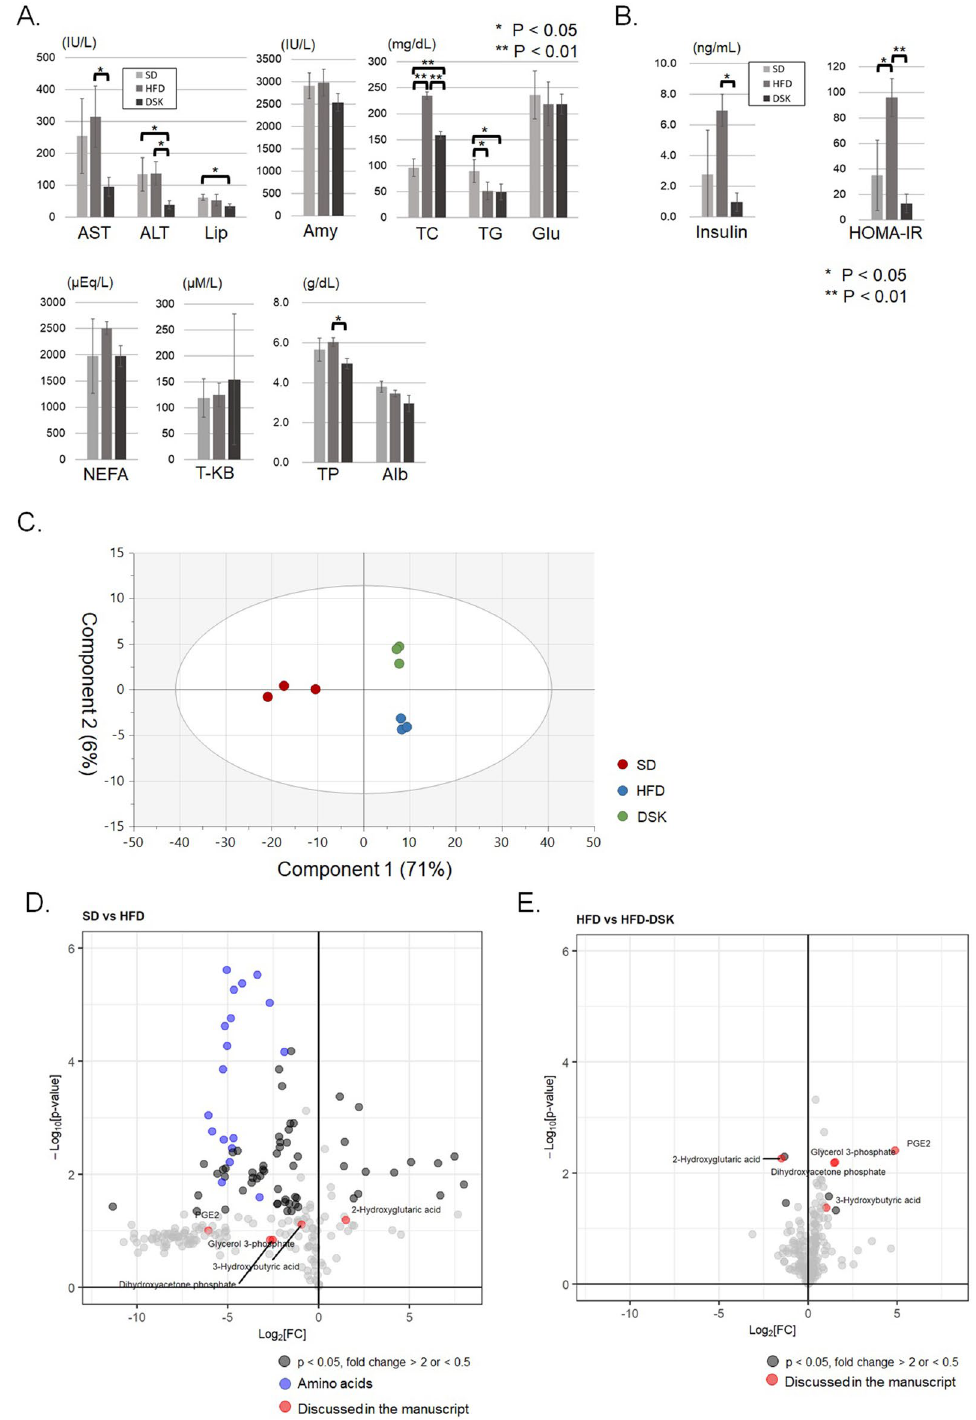
Figure 2. Effect of daisaikoto on fat metabolism in the liver. Total cholesterol and total protein levels were significantly lower in the DSK group than that in the HFD group; however, lipase, TG, glucose, and blood ketone levels were not significantly different ( A ). Serum insulin levels and HOMA-IR were significantly lower in the DSK group than that in the HFD group ( B , p < 0.05 and p < 0.01, respectively). The PLS-DA score plot showed that component 1 clearly (71%) discriminated against the effect of HFD and component 2 contributed to the separation of the DSK and HFD groups albeit at a low contribution ( C ). A volcano plot demonstrates that many amino acid levels in the liver were significantly decreased during HFD treatment ( D , P < 0.05, fold change > 2 or < 0.5). Regarding the effect of daisaikoto, the volcano plot indicated that daisaikoto administration changed 9 metabolite levels in the liver compared to the HFD group ( E ). AST aspartate aminotransferase, ALT alanine aminotransferase, Lip lipase, Amy amylase, TC total cholesterol, TG triglyceride, Glu glucose, NEFA non-esterified fatty acid, T-KB total ketone body, TP total protein, Alb albumin, HOMA-IR homeostasis model assessment-estimated insulin resistance, PLS-DA partial least squares-discriminant